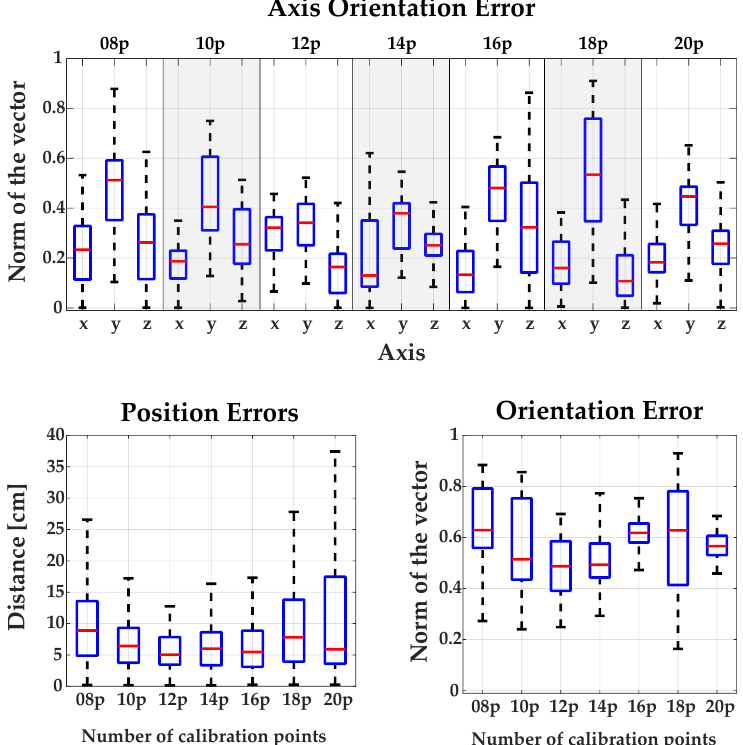
Figure A3. Results obtained by the RANSAC calibration method using different numbers of calibration